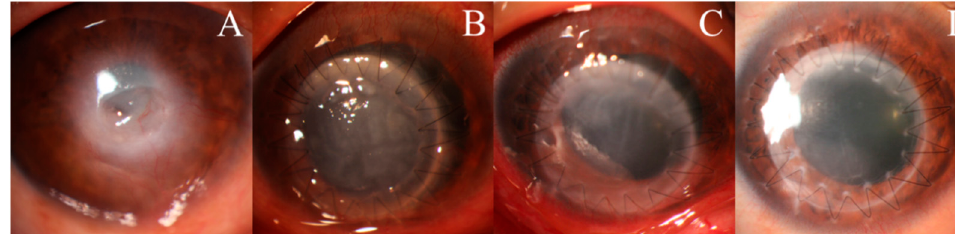
Figure 1. Anterior segment photographs of three UZS patients during the 3-month follow-up pe- riod. A 21-year-old male with keratoconus in his left eye: ( A ) preoperatively; ( B ) three days postop- eratively; ( C ) one month postoperatively; ( D ) three months postoperatively.